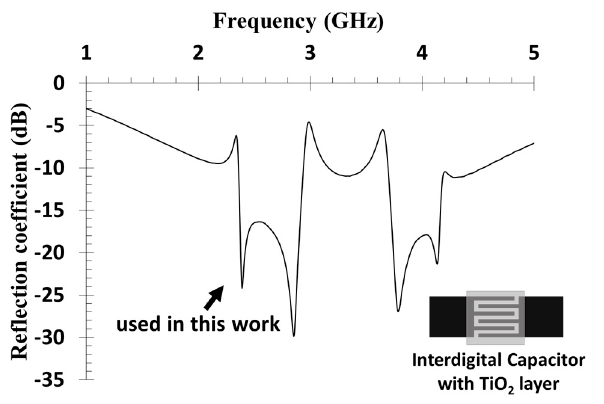
Figure 1. Reflection coefficient (S 11 dB) of the sensor covered with a layer of TiO 2 nanoparticles. Inset: design of the sensor (interdigital capacitor).